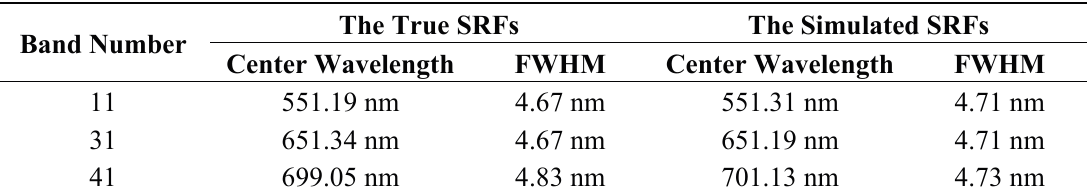
Table 1. The SRF comparison of the simulated calibration results of the sensor simulator and the results of the true